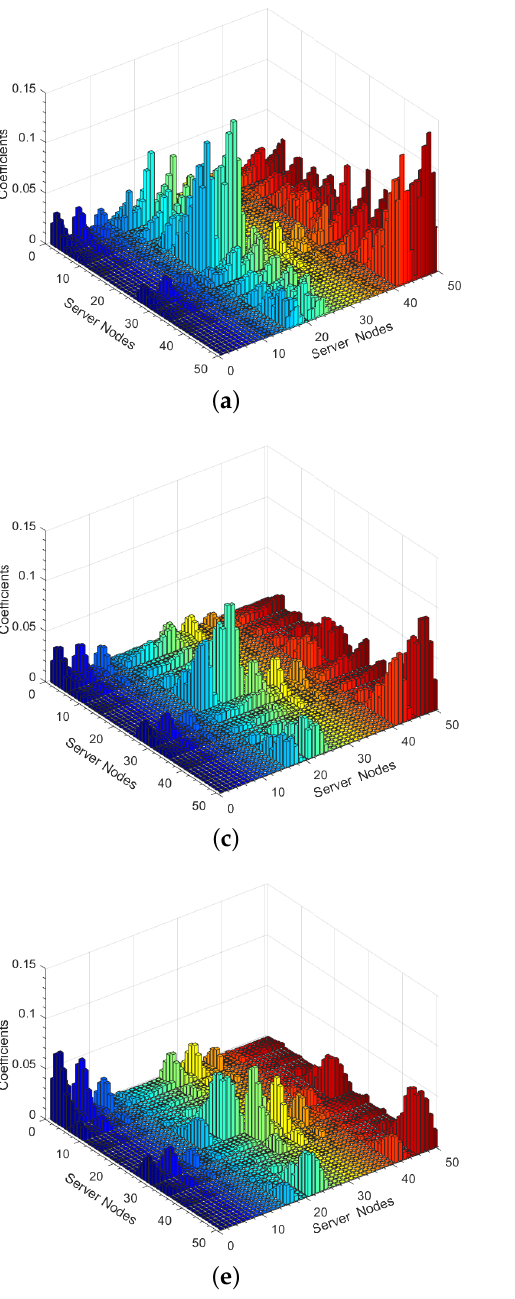
Figure 6. ( a ) POD reconstruction of cross-interference matrix for V sup = 8.19 m 3 /s. ( b ) Reconstruction error of cross-interference matrix for V sup = 8.19 m 3 /s. ( c ) POD reconstruction of cross-interference matrix for V sup = 10.71 m 3 /s. ( d ) Reconstruction error of cross-interference matrix for V sup = 10.71 m 3 /s. ( e ) POD reconstruction of cross-interference matrix for V sup = 13.23 m 3 /s. ( f ) Reconstruction error of cross-interference matrix for V sup = 13.23 m 3